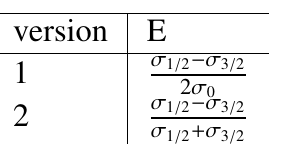
Table 2: Overview of di ff erent versions used to extract E asymmetry